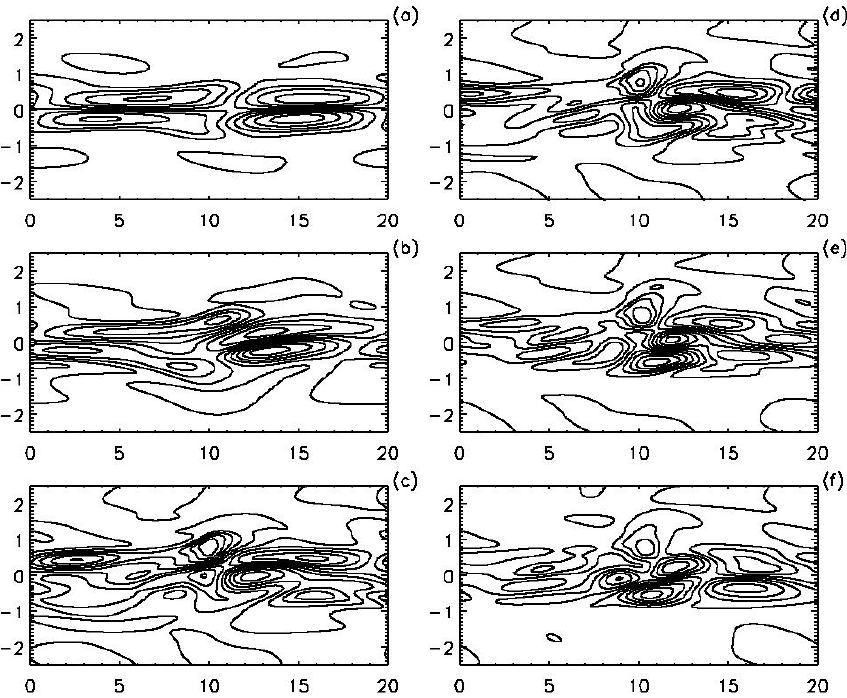
Fig. 16. Contour plots of potential temperature for the evolution of our initial perturbation in the presence of the dual ducting structure presented in Fig. 15, panel (b). Time are 23, 32, 53, 58, 64,